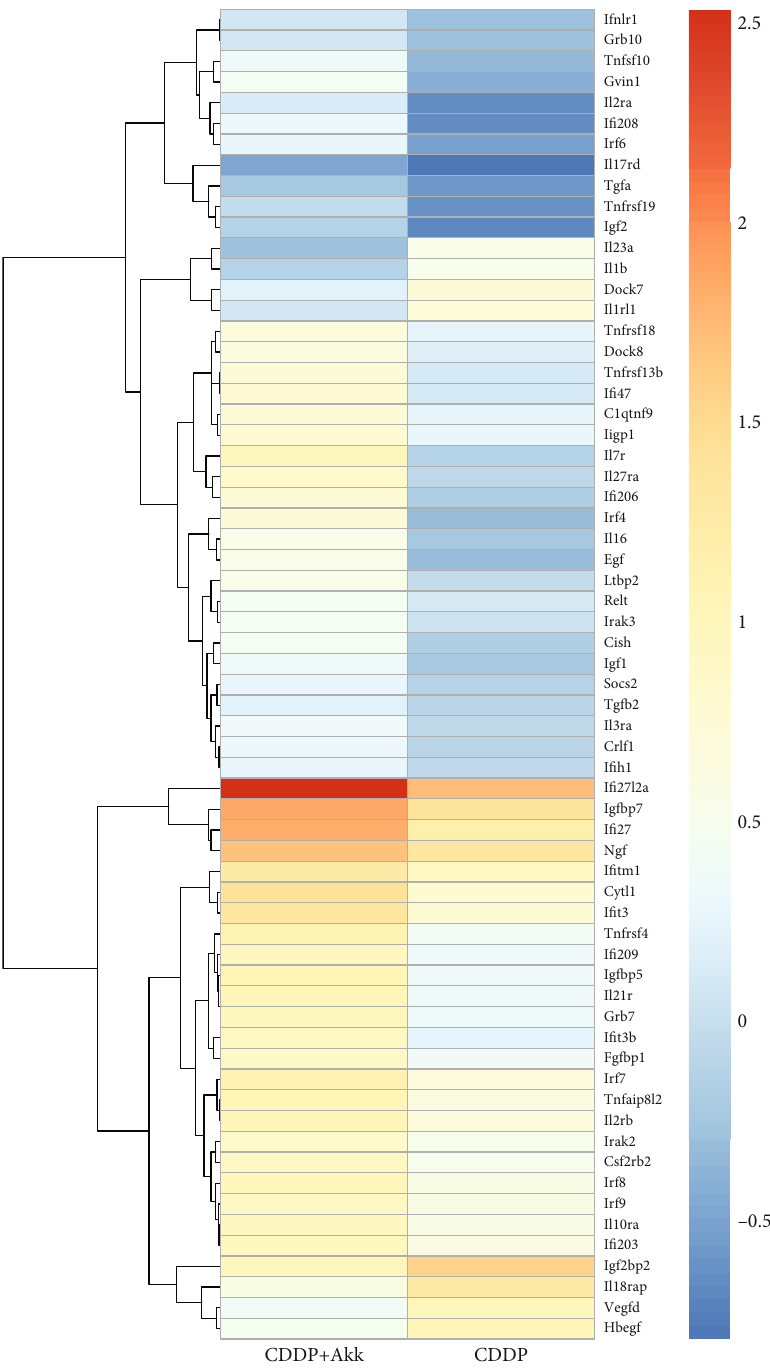
Figure 3: Comparison of immune-related di ff erential genes between the CDDP group and the CDDP+Akk group. The horizontal coordinate is the sample, and the vertical coordinate is the gene. Di ff erent colors represent di ff erent gene expression levels. The color ranges from blue to white to red, indicating low to high expression levels. High-expression genes are shown in red and low-expression genes are shown in dark